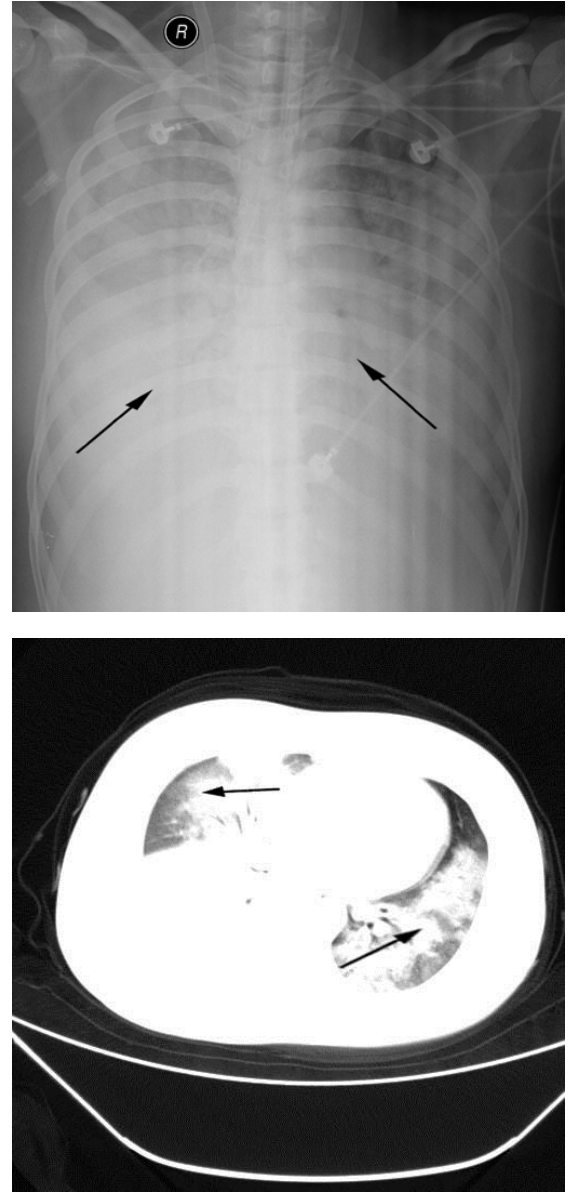
Figure 1. Pre-ECMO chest radiograph and computed